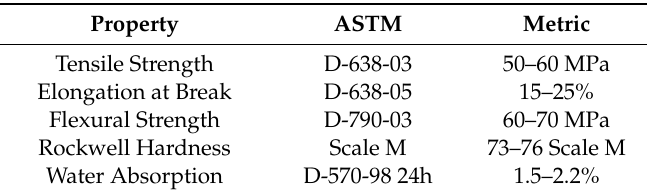
Table 1. Objet VeroBlue RGD840 properties [39].